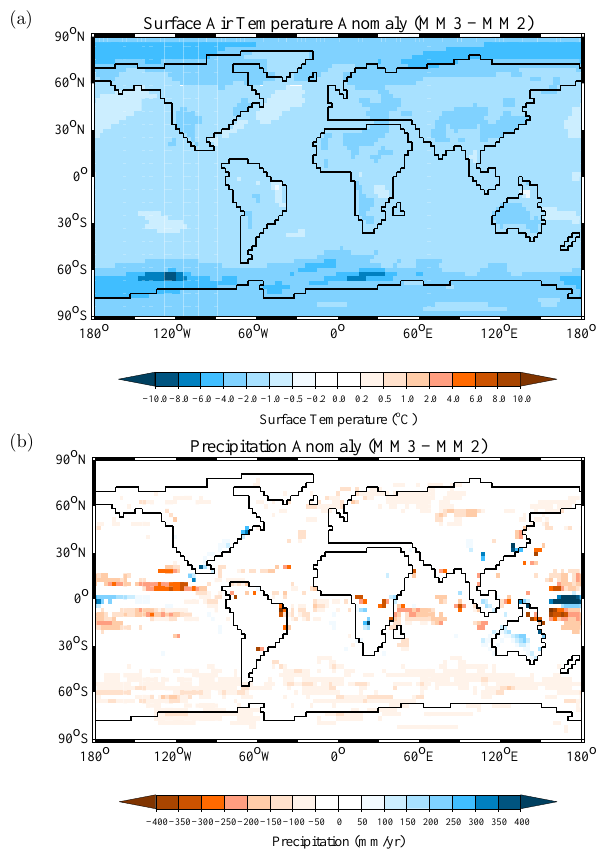
Fig. 15. (a) Annual mean surface temperature and (b) precipitation anomalies between experiments MM3 and MM2.